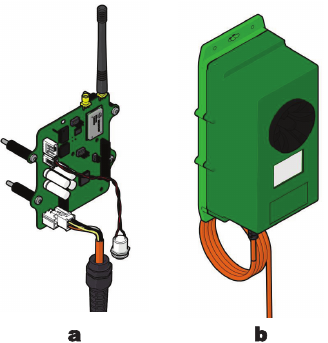
Figure 4. Repeller board sketch ( a ) wide open ( b ) in an